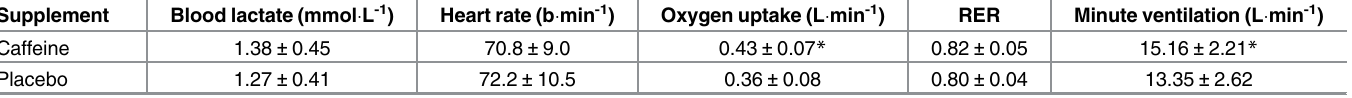
Table 2. The effects of caffeine supplementation on measures of blood lactate, heart rate, oxygen uptake, respiratory exchange ratio, and minute ventilation in the final 30 s of a 30 minute recovery period following submaximal incremental exercise. Values are means ± standard deviations. Supplement